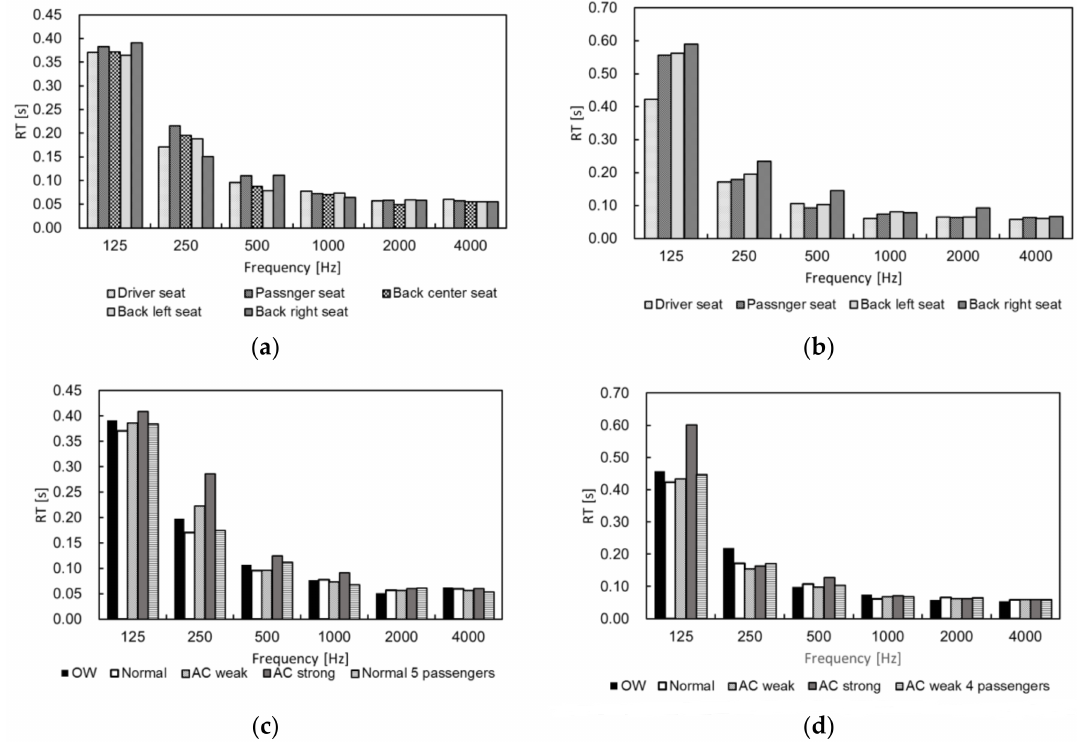
Figure 4. Measured reverberation time ( RT ) [s] at each passenger position in cars ( a ) A and ( b ) B and under open-window (OW), air-conditioner (AC) and multiple passenger settings in cars ( c ) A and ( d )